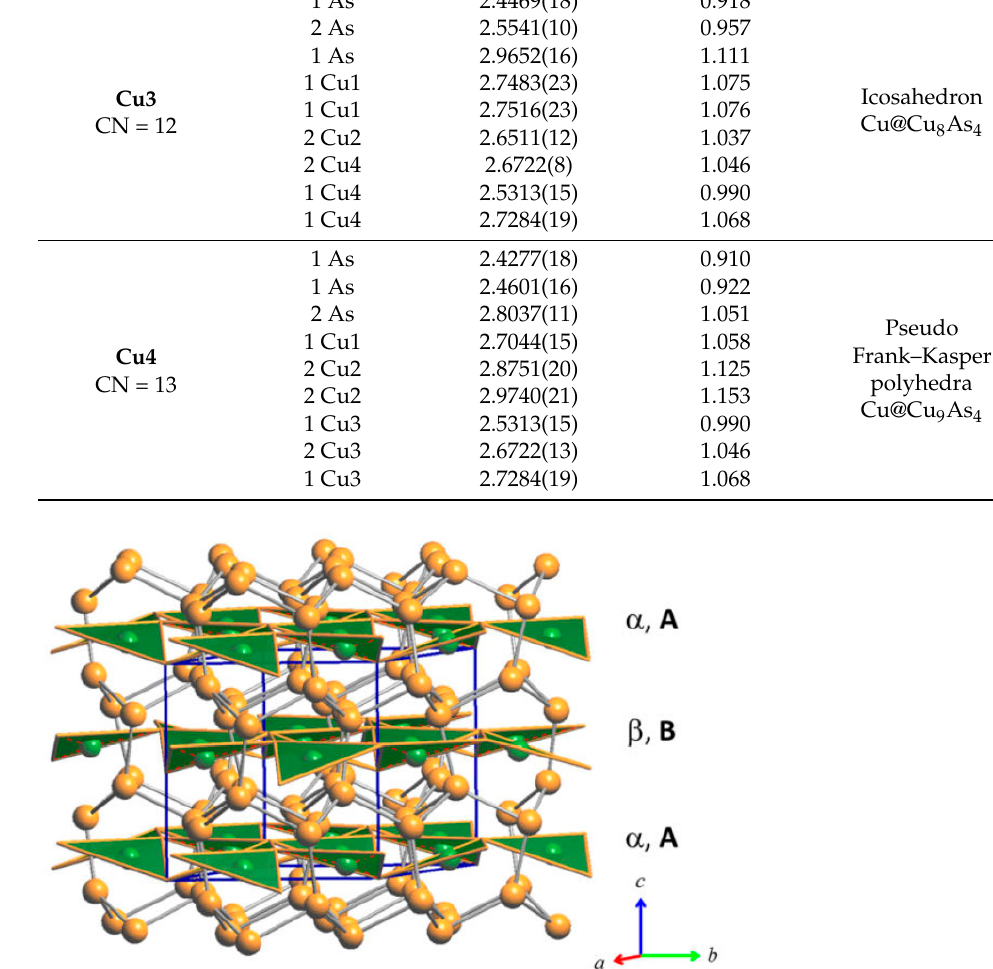
Figure 5. ( a ) Three triangular units sharing one vertex. ( b ) Perspective view of a layer formed by the ‘Cu 3 As’-triangular units. ( c ) Top view of the layer shown in ( b ). Note: for simplicity, in ( b ) and ( c ) the Cu atoms at the vertices of the ‘Cu 3 As’ units (Cu4 − Cu1 − Cu4) are not shown. Orange and green balls indicate Cu and As atoms, respectively.